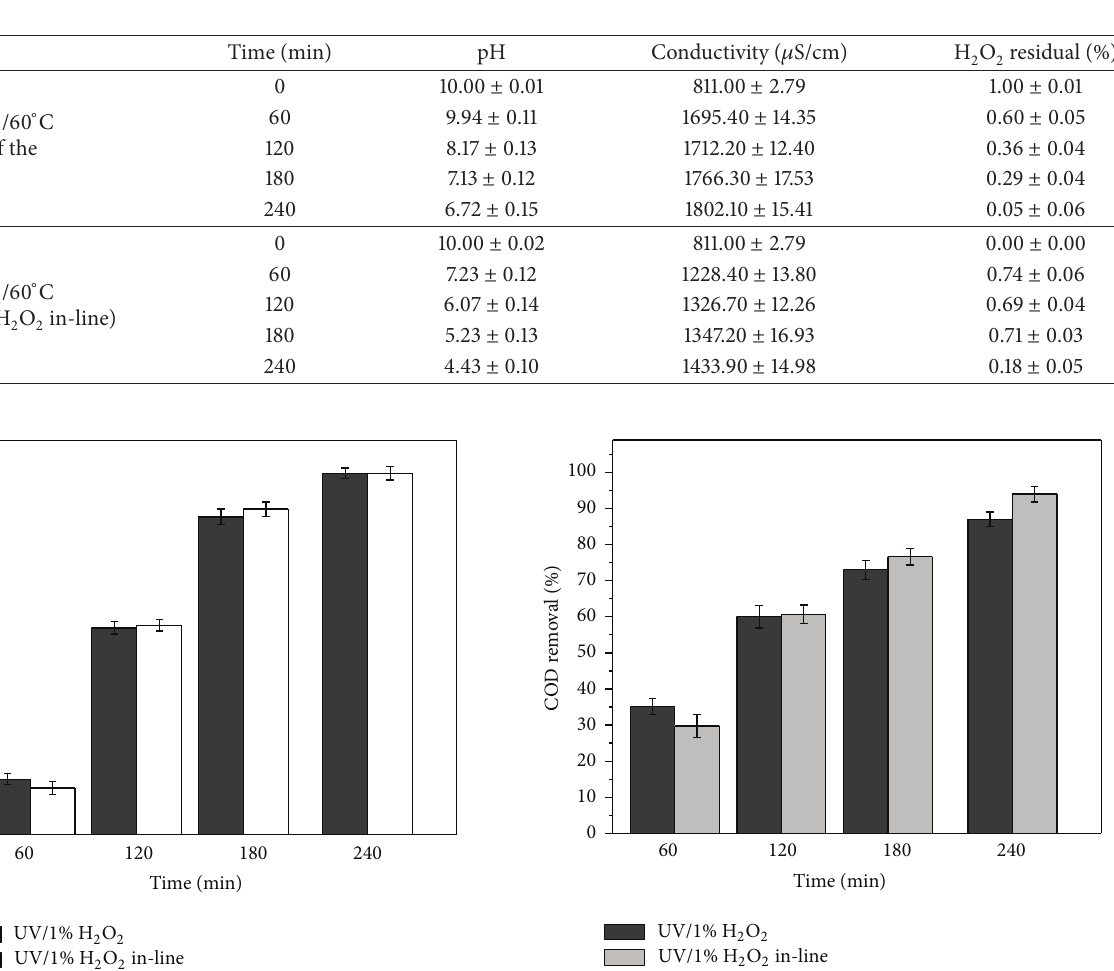
Figure 11: Effect of the in-line hydrogen peroxide addition on color removal. Experimental conditions: initial pH 10, UV/1% H 2 O 2 , and 60 ∘ C.